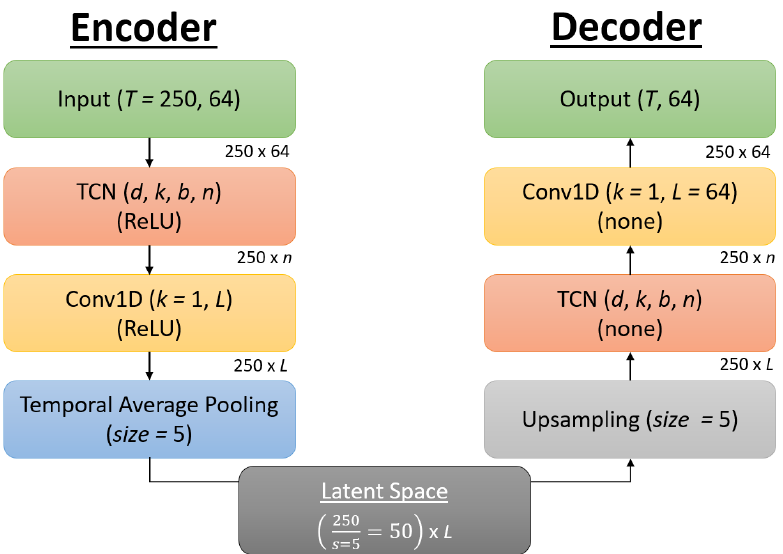
Figure 9. Visual representation of the TCN-AE architecture. Each block corresponds to a layer, with hyperparameters for that layer italicized . The activation function for the TCN and Conv1D layers is in parentheses, using ReLU for the encoder and no activation function for the decoder. The dimensions for the input are also provided in the upper-right of each layer as it passes throughout the architecture, with the dimensions starting at T = 250 for the sequence length and 64 representing the features (corresponding to the 64 electrodes). The latent space dimensions are 50 × L , with L being a